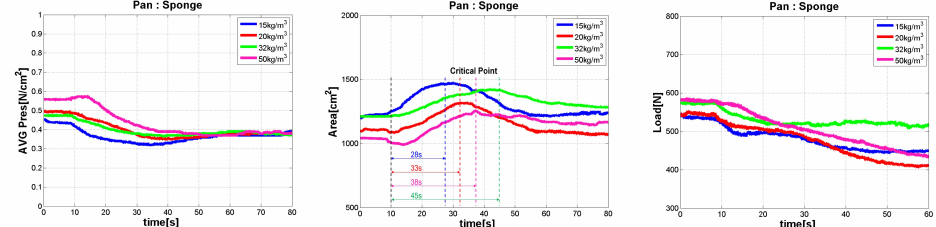
Figure 11. The result of material selection test Avg. pressure ( Left ), Contact Area ( Center ), Load ( Right ), (only sponge with various